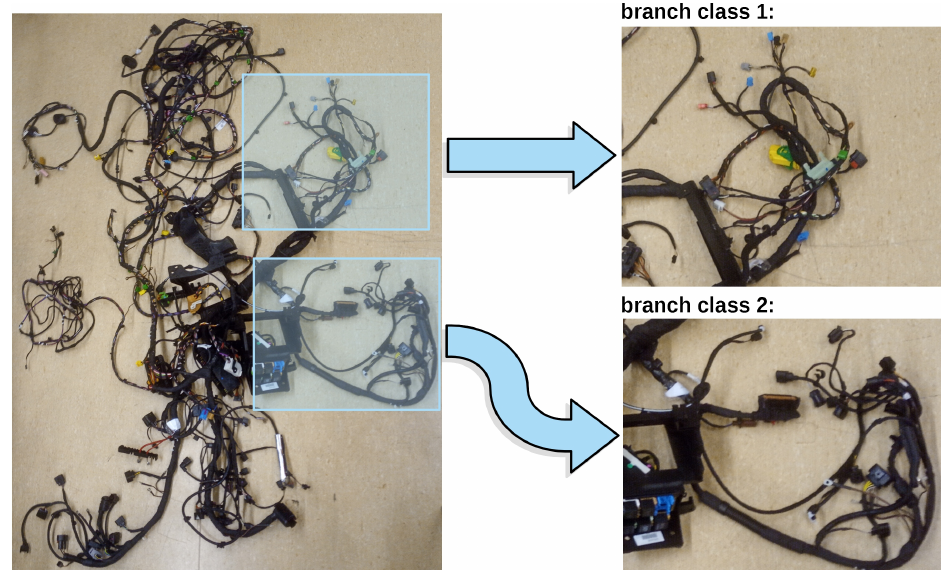
Figure 2. Sample image of the wiring harness. Example branches of two classes are highlighted in the source image and shown in detail on the